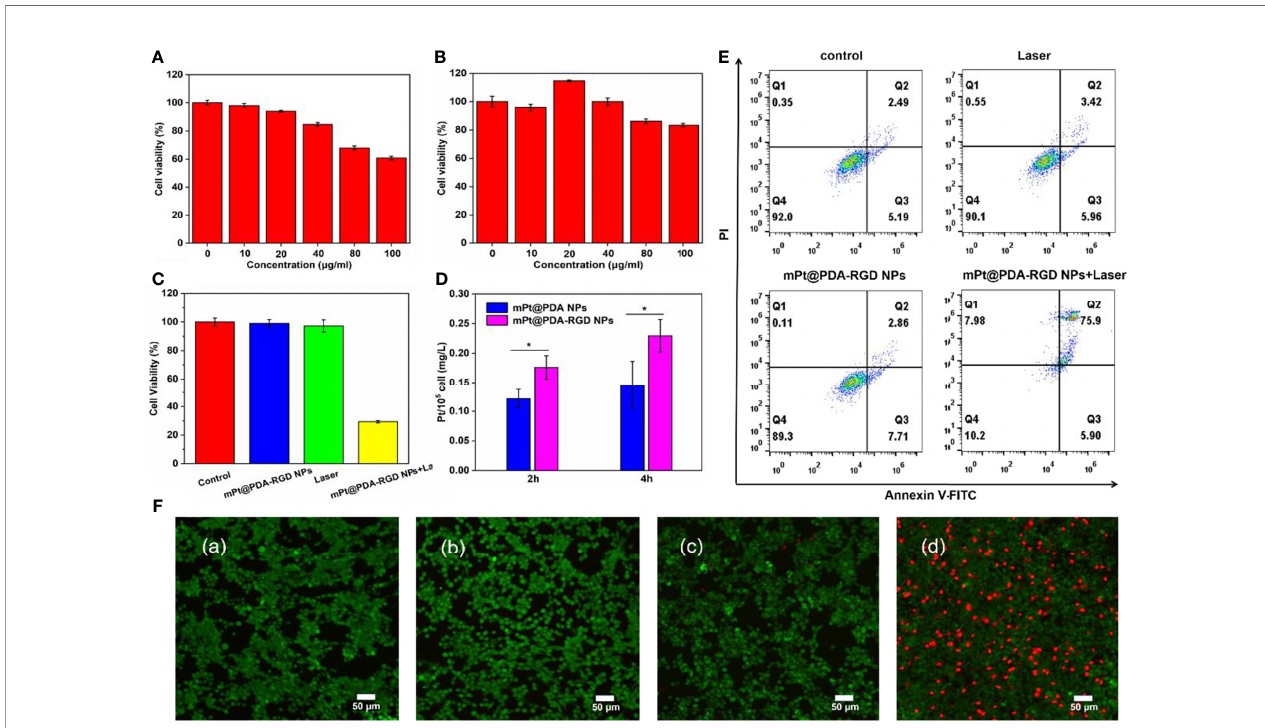
FIGURE 3 | Cytotoxicity of (A) mPt NPs and (B) mPt@PDA-RGD NPs. (C) Relative viability of SKOV-3 cells treated with mPt@PDA-RGD NPs and laser. (D) Pt contents in SKOV-3 cells with different treatments. All values are presented as means ± standard errors of the mean (SEM); *p < 0.05. (E) Flow cytometry analysis of SKOV-3 cells. (F) Calcein AM/PI staining of SKOV-3 cells with various treatments: (a) control, (b) laser (808 nm), (c) mPt@PDA-RGD NPs, (d) mPt@PDA-RGD